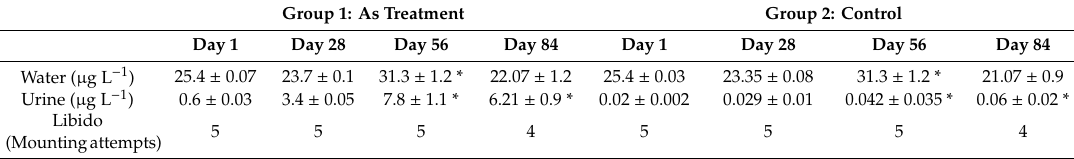
Table 2. E ff ects of arsenic on male Creole goats of the Region Lagunera– Ex situ treatment. Group 1: As Treatment Group 2: